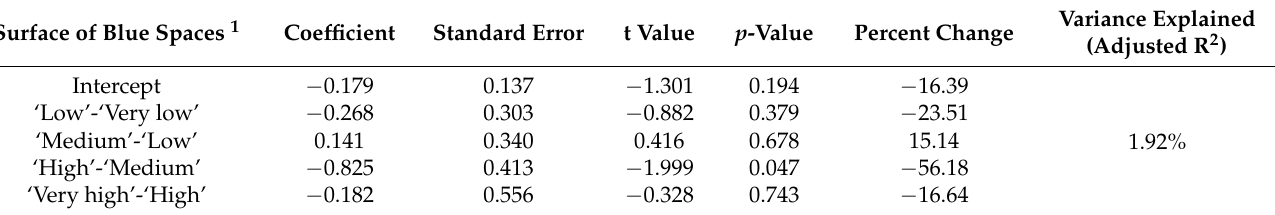
Figure 8. Distribution of surface of lacustrine blue spaces by IMU. ( a ) Bar plot for totals, ( b ) box plot for medians and interquartile ranks in logarithmic scale. Table 5. Results from models for the surface of blue spaces and the UMI for backward contrasts.